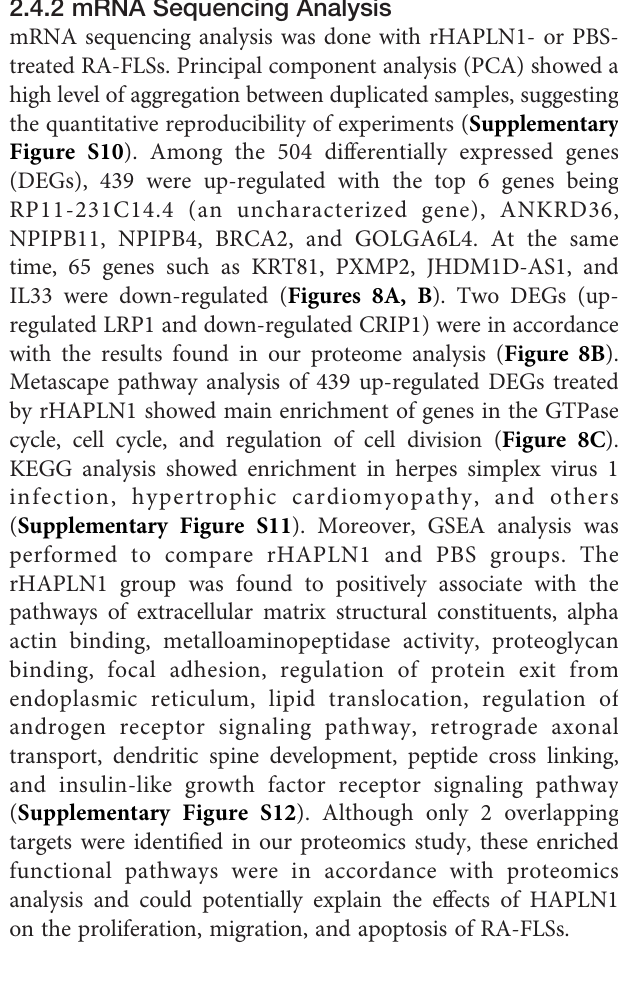
FIGURE 6 | The effects of si-HAPLN1 and HAPLN1 OE on RA-FLS-derived cytokines. (A, B) si-HAPLN1 transfection to RA-FLSs inhibited TNF- ɑ , IL-6, MMP1, MMP3, and MMP9 mRNA and protein expression; the mRNA level of AMPK- ɑ was reduced, but AMPK- ɑ and pAMPK- ɑ were up-regulated in the protein level. Expression of Cyclin D1 seems unaffected by si-HAPLN1 transfection. (C, D) After over-expression of HAPLN1 in RA-FLSs, TNF- ɑ , IL-6, and MMP9 mRNA and protein expressions were up-regulated while AMPK- ɑ was down-regulated at the mRNA level but AMPK- ɑ and pAMPK- ɑ were up- regulated at the protein level. Cyclin D1 proved to be down-regulated in the protein level by HAPLN1 OE transfection. (E) In control si-RNA-treated RA-FLSs form multiple tests, (E – G) AMPK- ɑ mRNA positively correlated with HAPLN1, TGF- b , and ACAN. (H-J) HAPLN1 mRNA shows positive correlations with fi bronectin, TGF- b , and IL-6 expression. * p < 0.05; * * p < 0.01; ** * p < 0.001; *** * p < 0.0001; ns, not signi fi cant. si-Control, negative control management of si-HAPLN1 transfection; Control OE , negative control management of HAPLN1